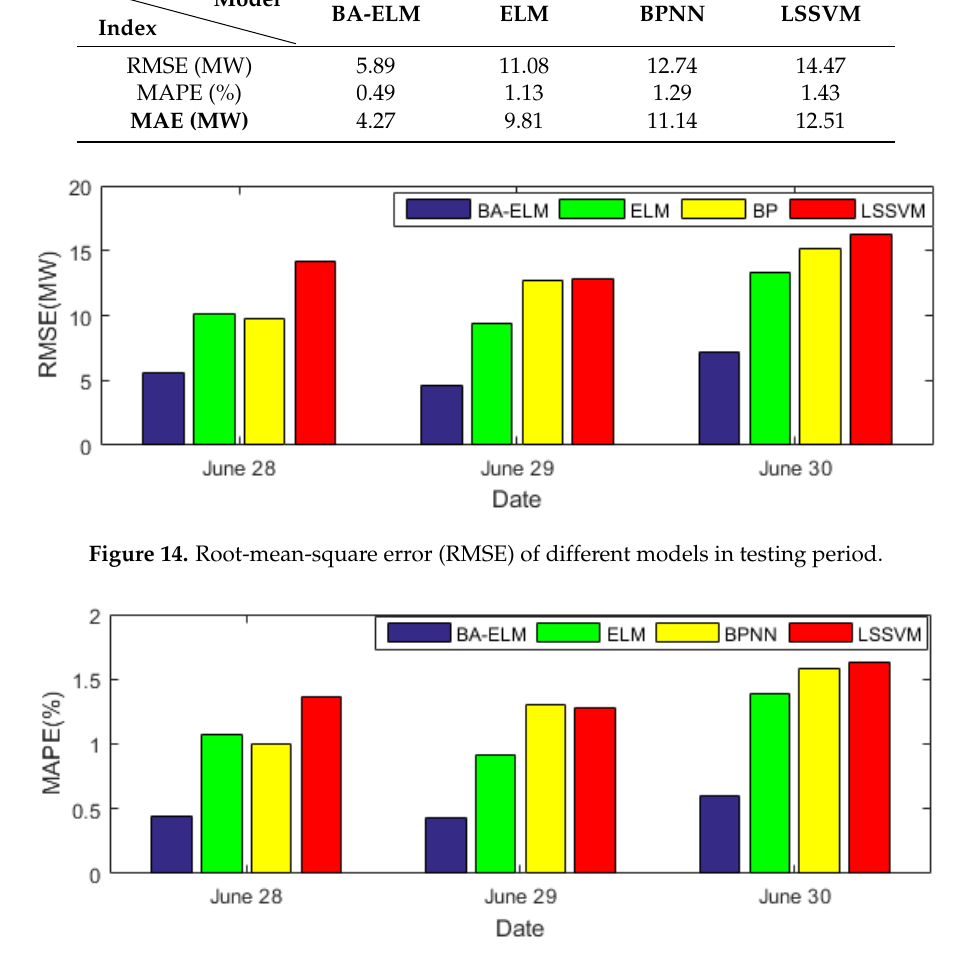
Figure 15. Mean absolute percentage error (MAPE) of different models in testing period.